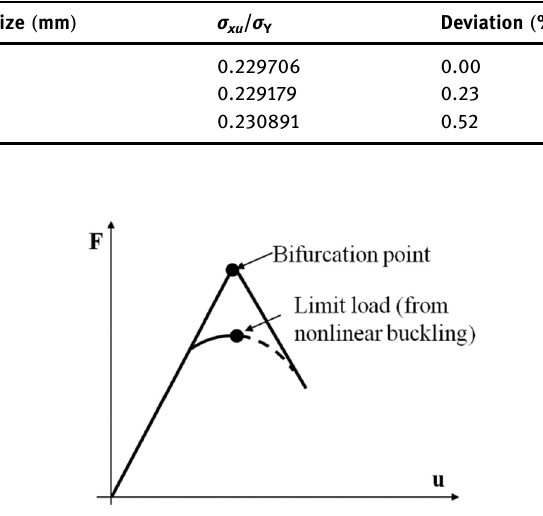
Figure 3: Linear ( eigenvalue ) and nonlinear buckling curves.